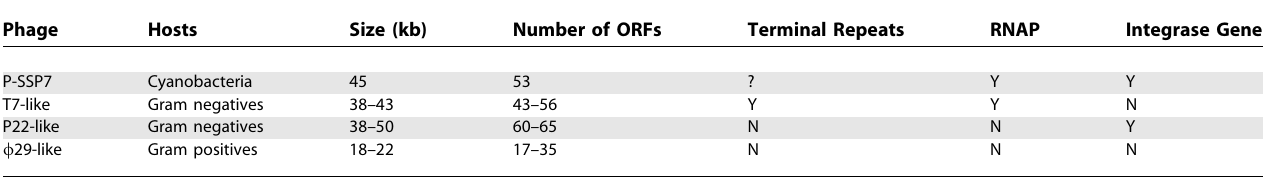
Table 1. Genome-Wide Characteristics of the Prochlorococcus Cyanophage P-SSP7 Relative to the Other Recognized Phage Groups within the Podoviridae [105]